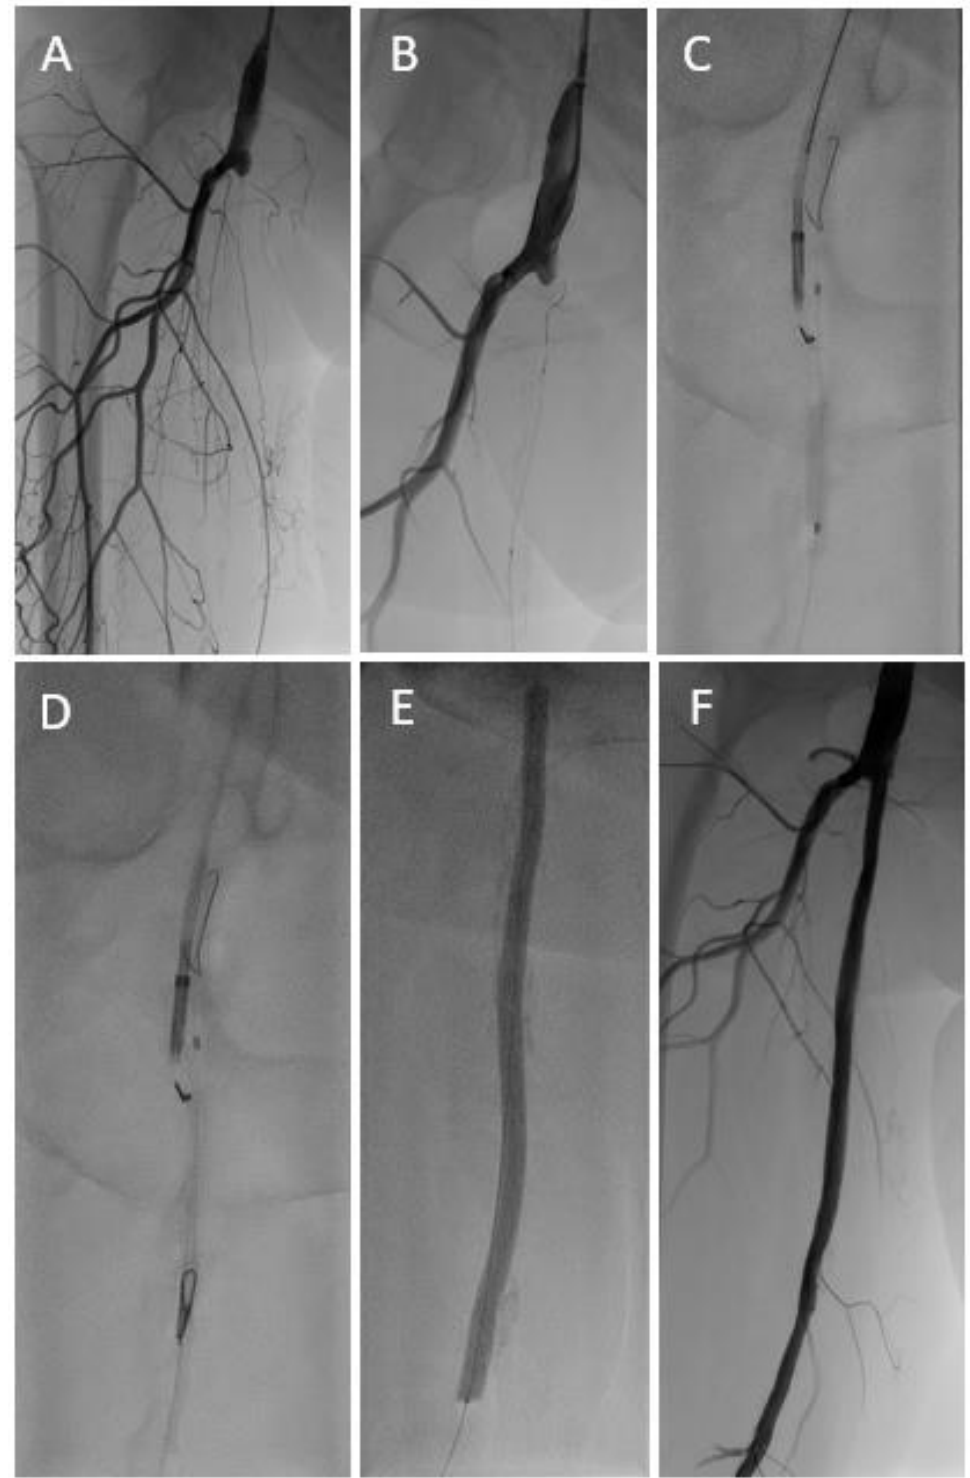
Figure 1. Long occlusive lesion ( A ) with initially unsuccessful recanalization attempts via both the antegrade and retrograde ( B ) route. A target-balloon was inserted via the retrograde access and punctured with the re-entry needle of an Outback™ catheter ( C , D ). After predilatation with a standard balloon followed by drug coated balloon angioplasty ( E ), an acceptable result was achieved without the need for subsequent stent implantation ( F ).